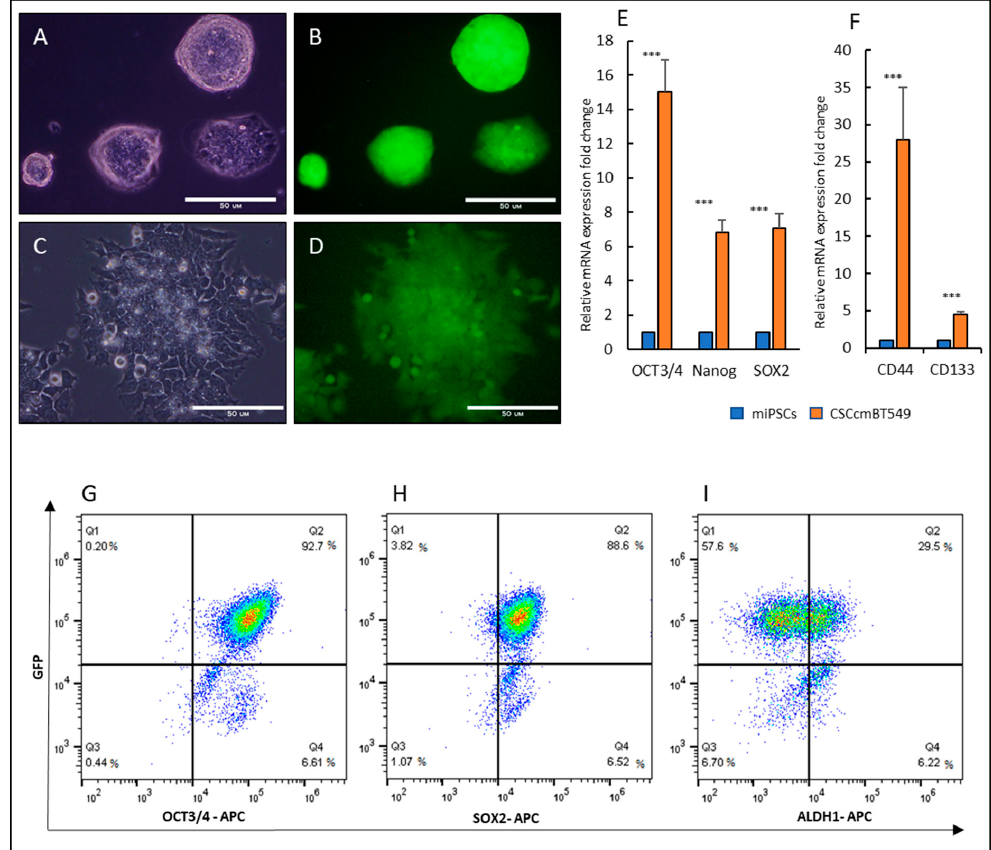
Figure 1. Morphology and Expression of GFP, stemness and cancer stem cell markers in CSCcmBT549 cells when compared with those in mouse induced pluripotent stem cells (miPSCs). ( A , B ) Representative images of miPSCs colony morphplogy using the bright field and fluorescence showing the expression of GFP in culture media with LIF. Scale bars represent 50 μ m. ( C , D ) Representative images of CSCcmBT549 cells using bright field and fluorescence showing the expression of GFP in